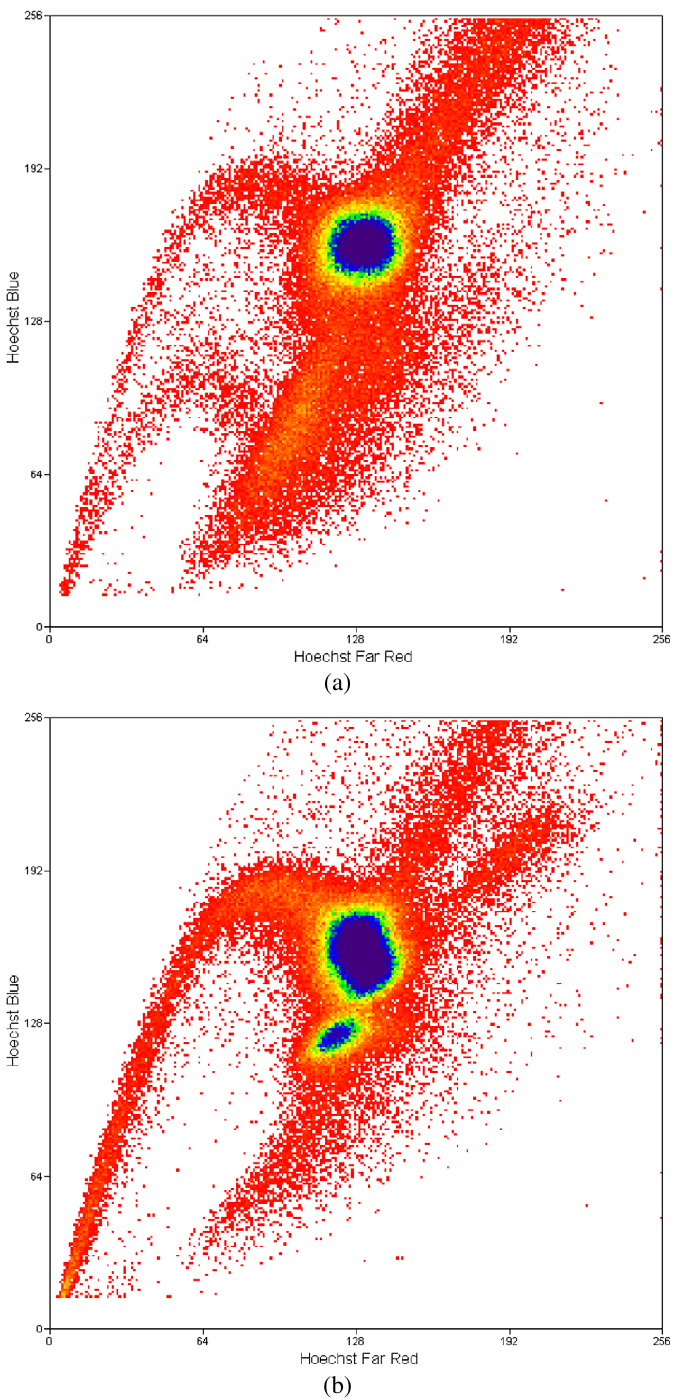
Fig. 7. Efflux of Ho342 in human bone marrow SP cells is not impaired by ammonium chloride-based lysing solutions. Cell preparation by density gradient separation (a) and using NH 4 Cl lysing solution